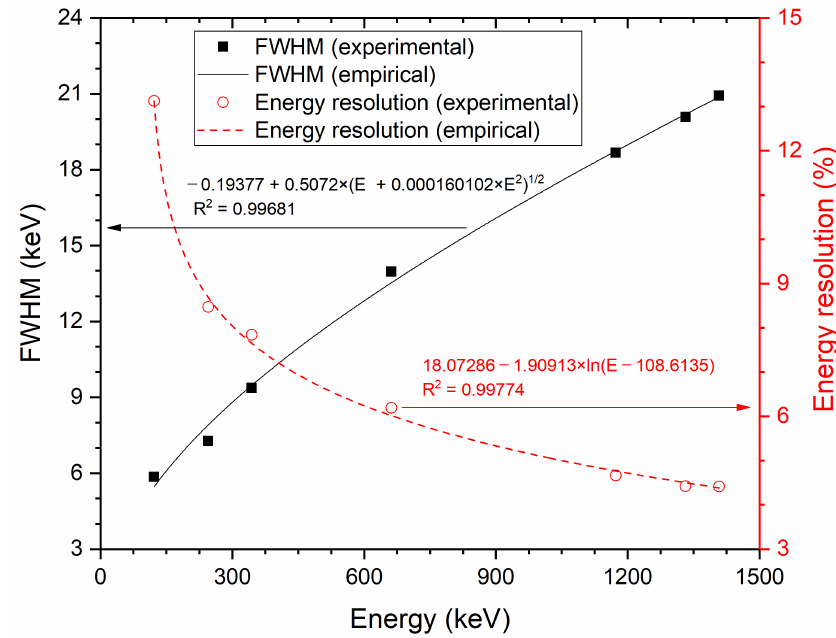
Figure 6. FWHM and energy resolution as functions of energy (in